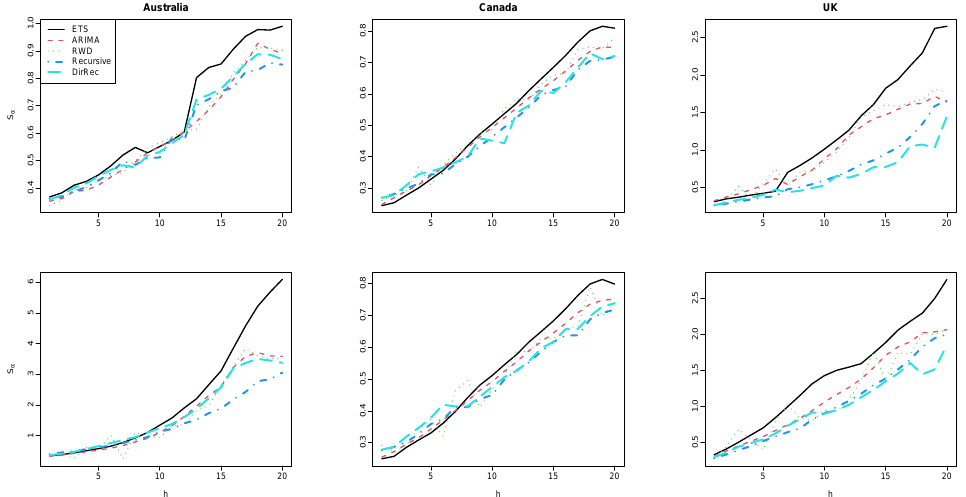
Figure 7. Computed S α values of log mortality rates for Australia ( first column ), Canada ( second column ), and the UK ( third column ). The results for the female group are given in the first row, while the results for the male group are given in the second